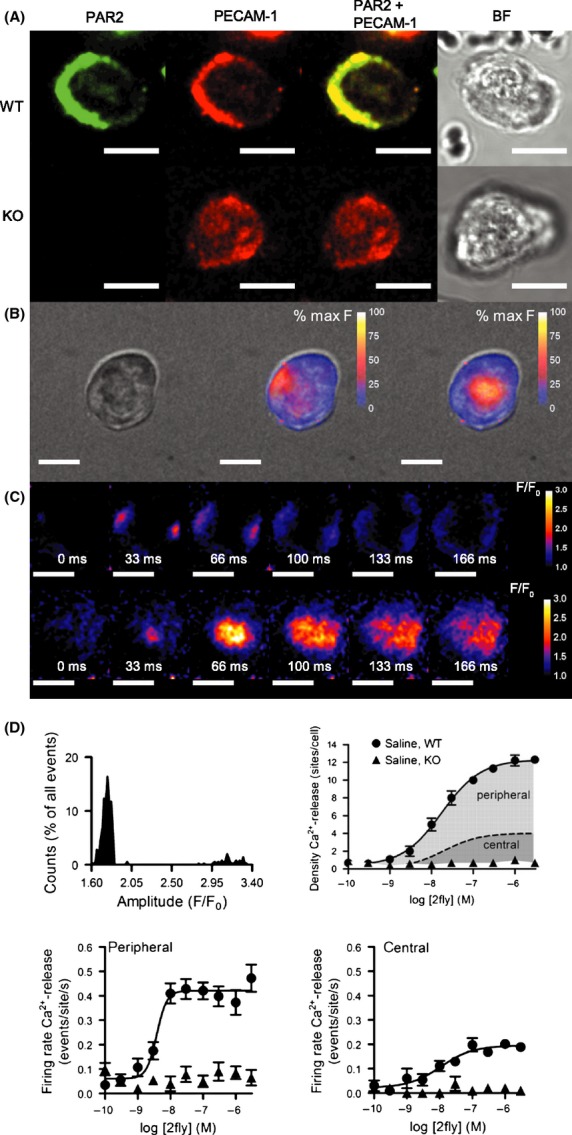
Identification and characterization of PAR2 Ca2+-release events in EC of small caliber arteries in the healthy state. (A) Immunofluorescence detection of PAR2 alone (green), platelet endothelial cell-adhesion molecule (PECAM-1) alone (red), PAR2 merged with PECAM-1 and bright field (BF) images in EC from PAR2 WT and KO mice, after 14 days infusion with saline. Fixed permeabilized small caliber mesenteric arterial EC incubated with B5- and PECAM-1 primary, and FITC- and Texas Red-conjugated secondary antibodies. Yellow indicates overlap of PAR2 and PECAM-1. (B) Fluo4-Ca2+ fluorescence 2D spinning disk CM data superimposed on BF image of EC during exposure to PAR2 agonist 2fly (3 μmol/L). Two-dimensional raw instantaneous fluorescence (F) data (30 frames sec−1) were converted and calibrated to 8-bit gray scales (255 = 100%). Peripheral (middle column) and central (right column) events are shown at the peak amplitude. (C) Ratio (F/F0) images of the time- and space-courses for peripheral (upper row) and central (lower row) events in EC exposed to 2fly. EC is the same cell shown in B. Ratio images were calculated by dividing a reference frame (F0) into the subsequent frames (F). Each frame in the time-courses follows after F0. In the upper row, two events with separated peripheral origins are shown occurring simultaneously. (D) Frequency distribution of the measured peak amplitudes of all Ca2+ events (N = 303) elicited by 2fly (3 μmol/L) in n = 10 cells isolated from saline WT EC. Amplitude bin size was 0.02 F/F0. Concentration-response data for PAR2-activating peptide 2fly in EC (n = 10 cells/point; 100 cells for each curve) from WT and KO. Density of total Ca2+-release events in WT EC exposed to 2fly is the sum of the area shaded dark gray under dashed line indicating the number of central events and the area shaded light gray above dashed line indicating number of peripheral events. Firing rates of the peripheral and central events in WT and KO EC exposed to 2fly. Data were acquired as described in B–C in separate EC. For all images white bar = 10 μm.